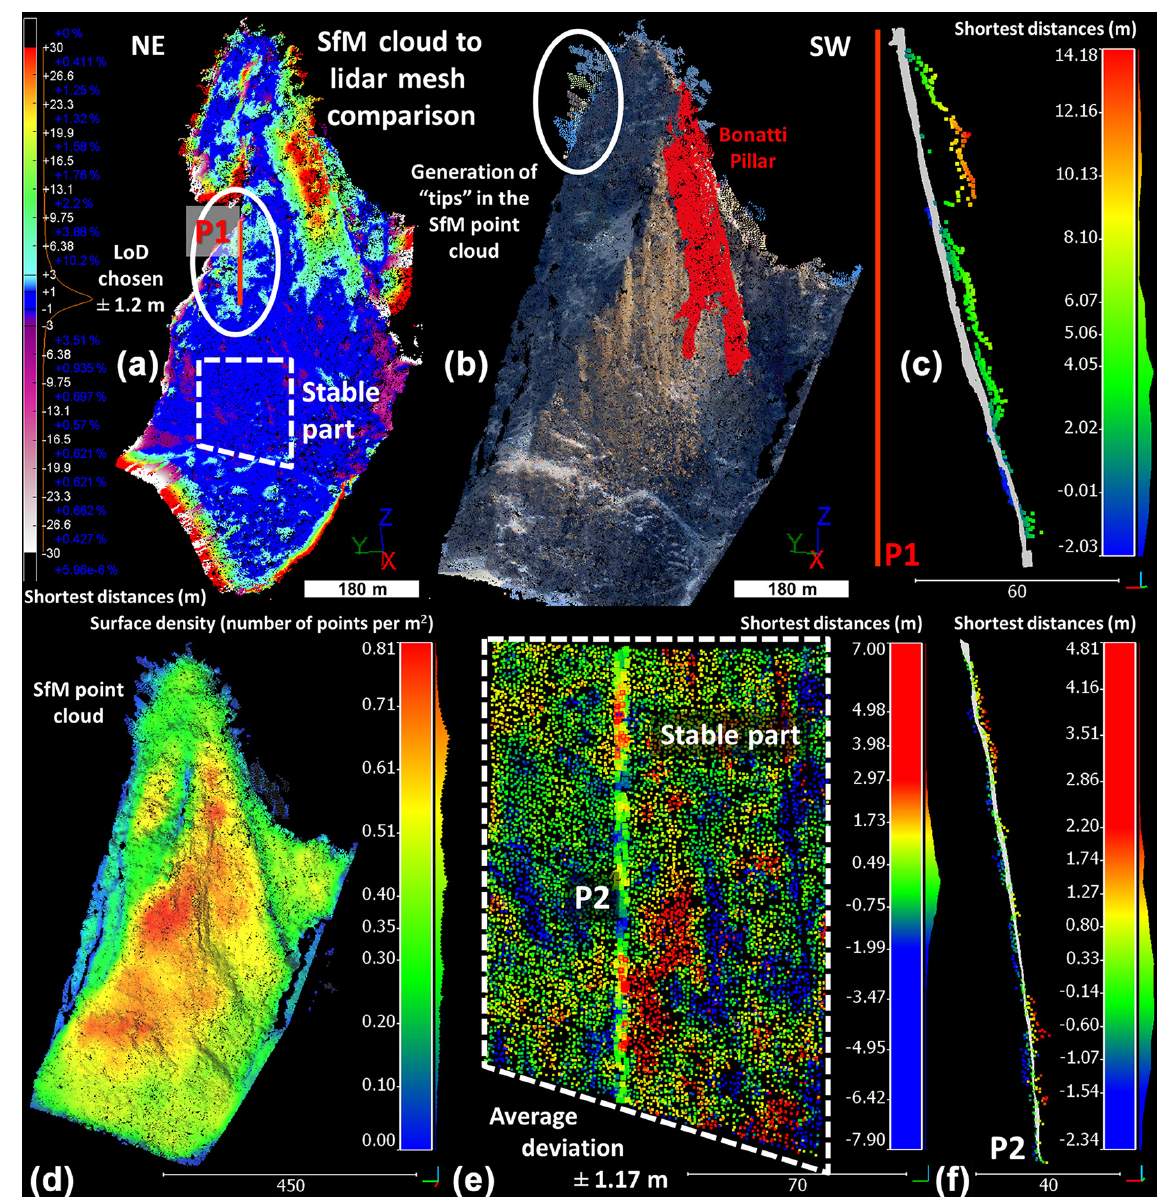
Figure 3. SfM–lidar comparison. (a) Result of the point-to-mesh comparison between the SfM point cloud and the reference lidar mesh. The color scale of the shortest distances is divided into two parts: positive deviations from blue to red and negative deviations from blue to white. (b) SfM point cloud of the Drus with, in red, the positive deviations extracted from the comparison and associated with the Bonatti Pillar collapse. The two white ellipses illustrate the artifacts that form “tips” in the SfM model, and the red line located in the center of the left ellipse corresponds to the longitudinal cross section P1 that passes through the lidar mesh and the SfM point cloud. This cross section is visible in (c) , where the grey points correspond to the lidar mesh, while the colored points come from the SfM model. (d) Point density map of the SfM model (number of points per square meters). (e) Point-to-mesh deviations observed in the stable area framed in (a) with the localization of the longitudinal cross section P2 (highlighted points). This cross section is visible in (f) , where the grey points correspond to the lidar mesh, while the colored points come from the SfM